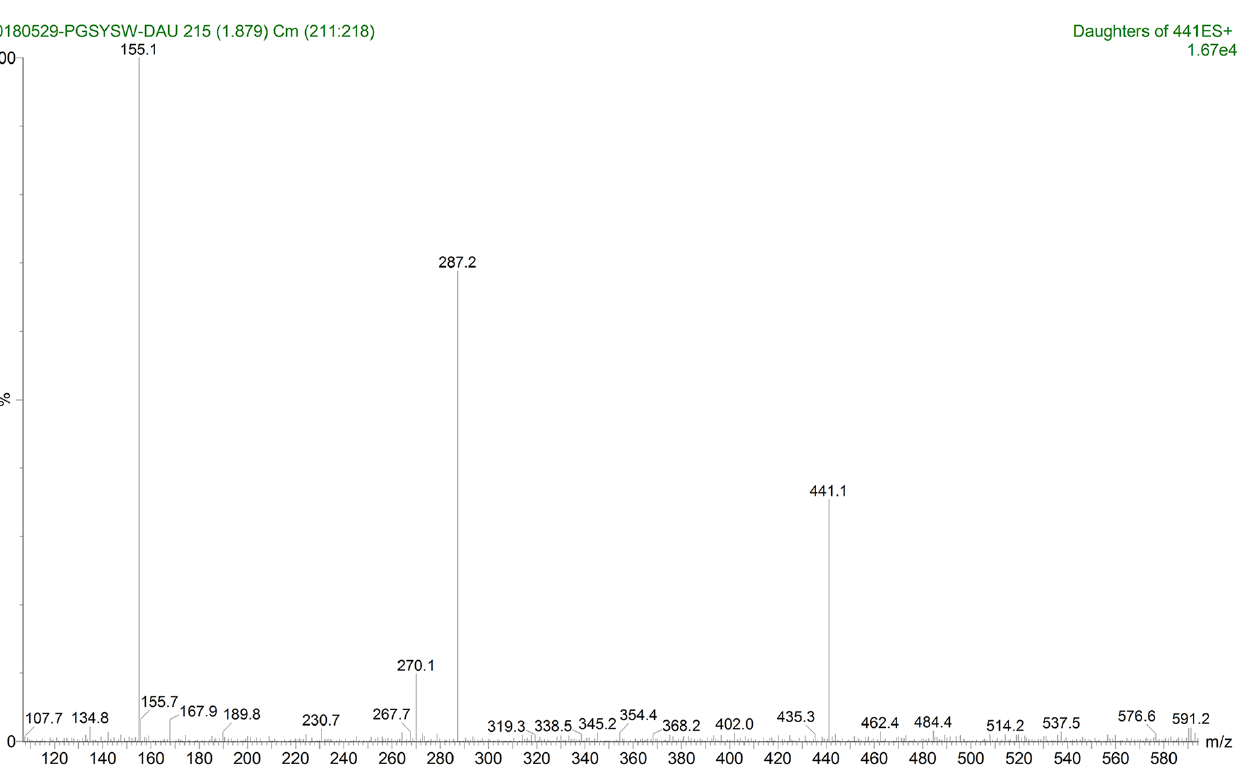
FIGURE 3 - The tandem mass spectrum (MS/MS) of DL-malic acid